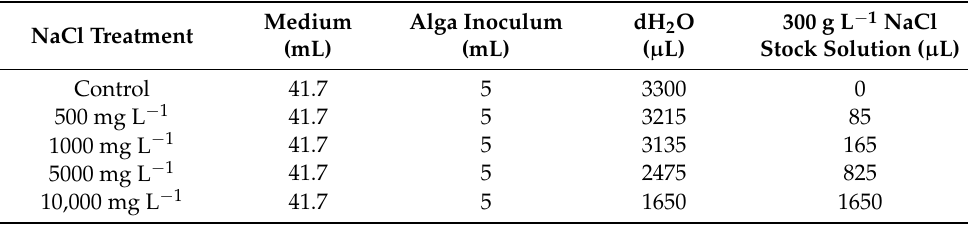
Table 2. Salt treatment of Coelastrum morus cultured in media with different nutrient content and N:P